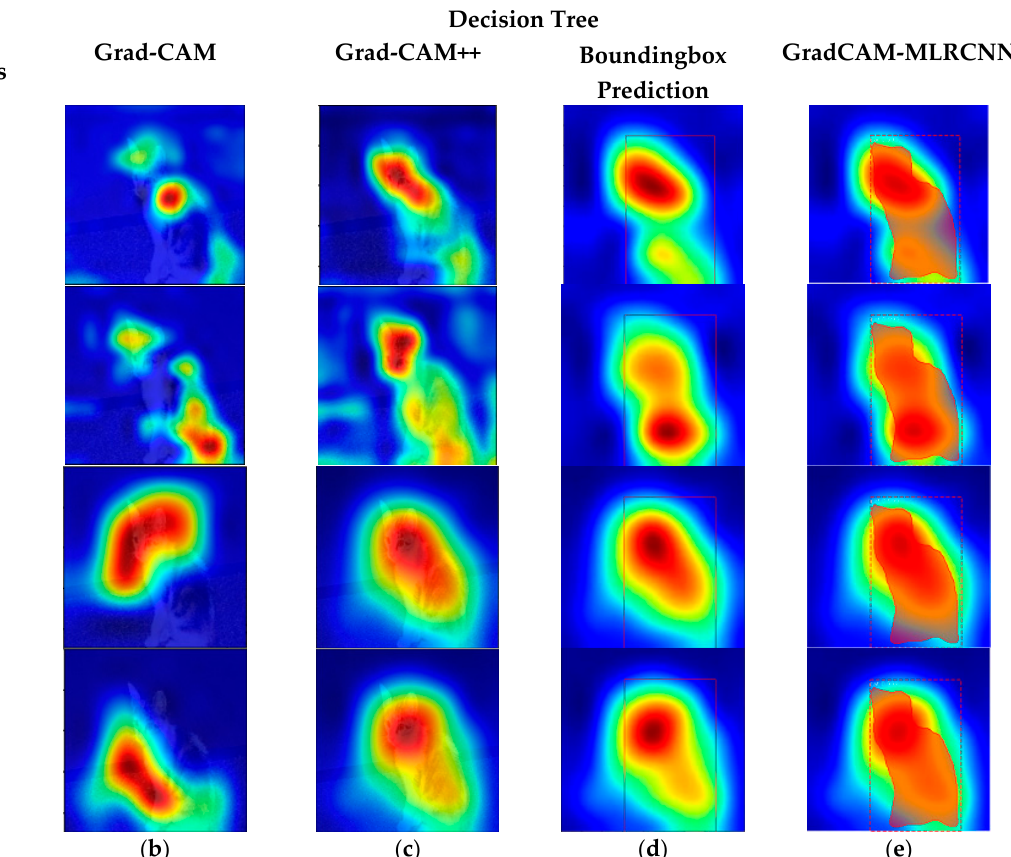
Figure 9. ( a ) Various pre-trained models; ( b ) results of Grad-CAM; ( c ) results of Grad-CAM++; ( d ) bounding box prediction on Grad-CAM++; and ( e ) GradCAM-MLRCNN.